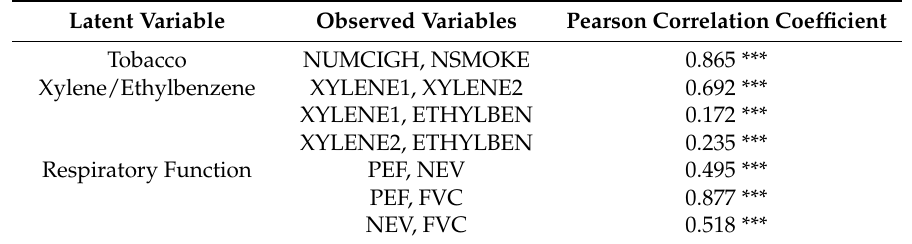
Table 2. Weighted Pearson correlation coefficients of observed variables within latent variable measures among youth receiving the VOC supplement (n =